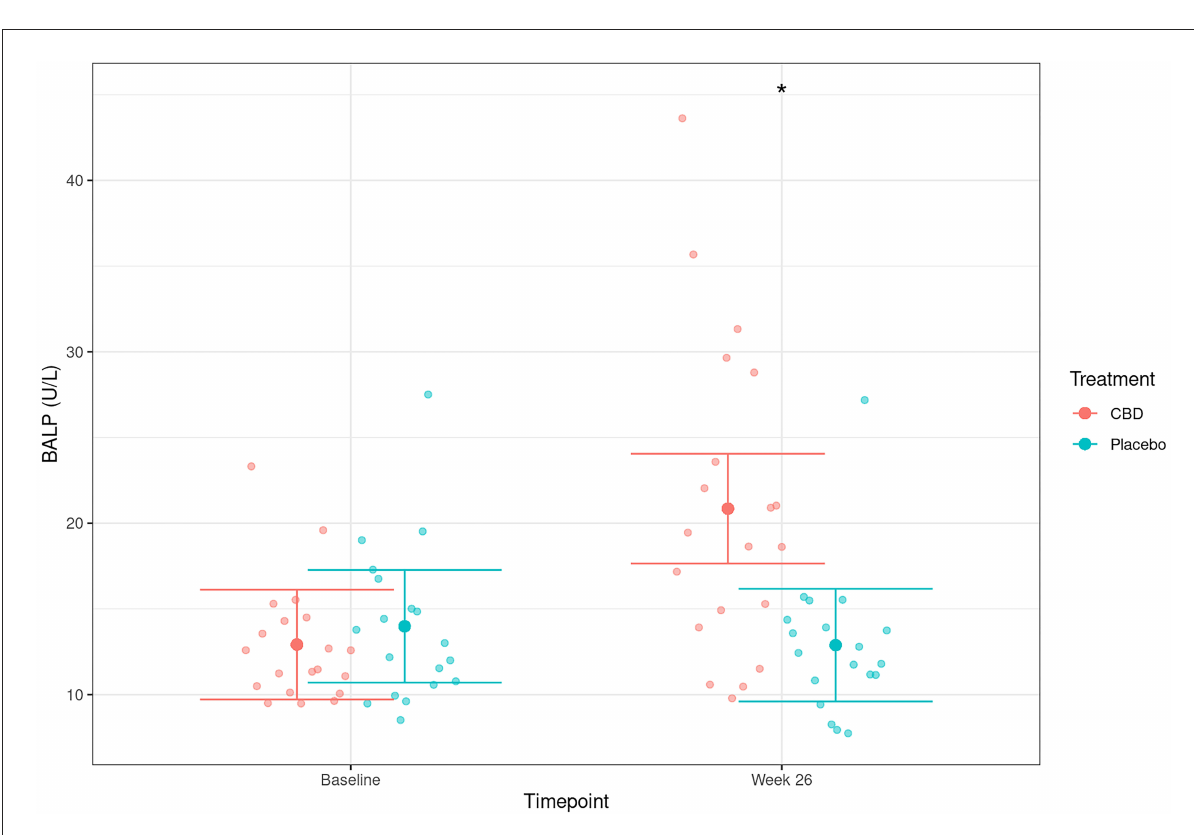
comparisons being made in 5 domains, a Bonferroni adjustment to the alpha level was used, resulting in a test level of p ≤